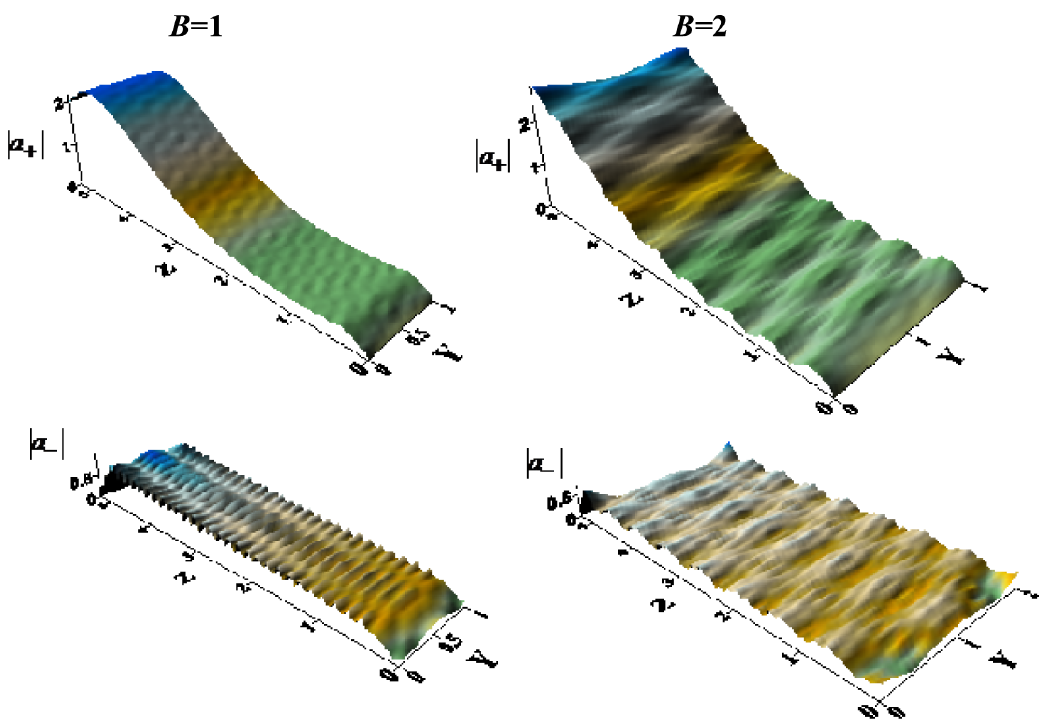
FIG. 3. Spatial structures of the propagating partial waves a (cid:4) in the steady-state regime for the same parameters as in Fig. 2: B ¼ 1 (left), B ¼ 2 (right).